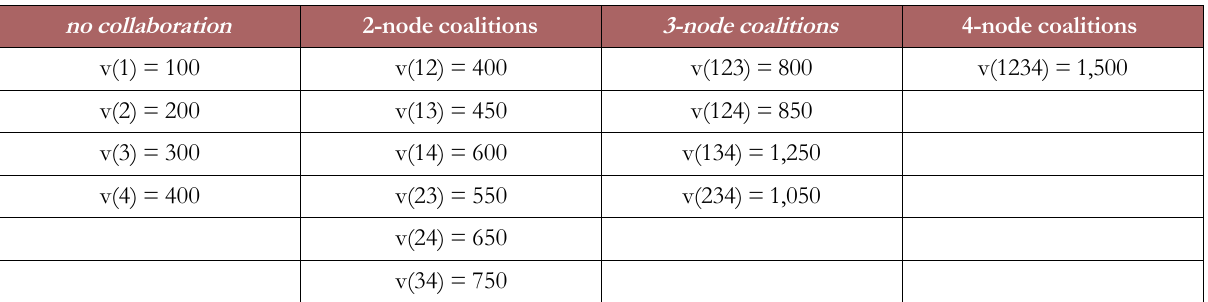
Table 1. Net profit for the different possible coalitions in the supply